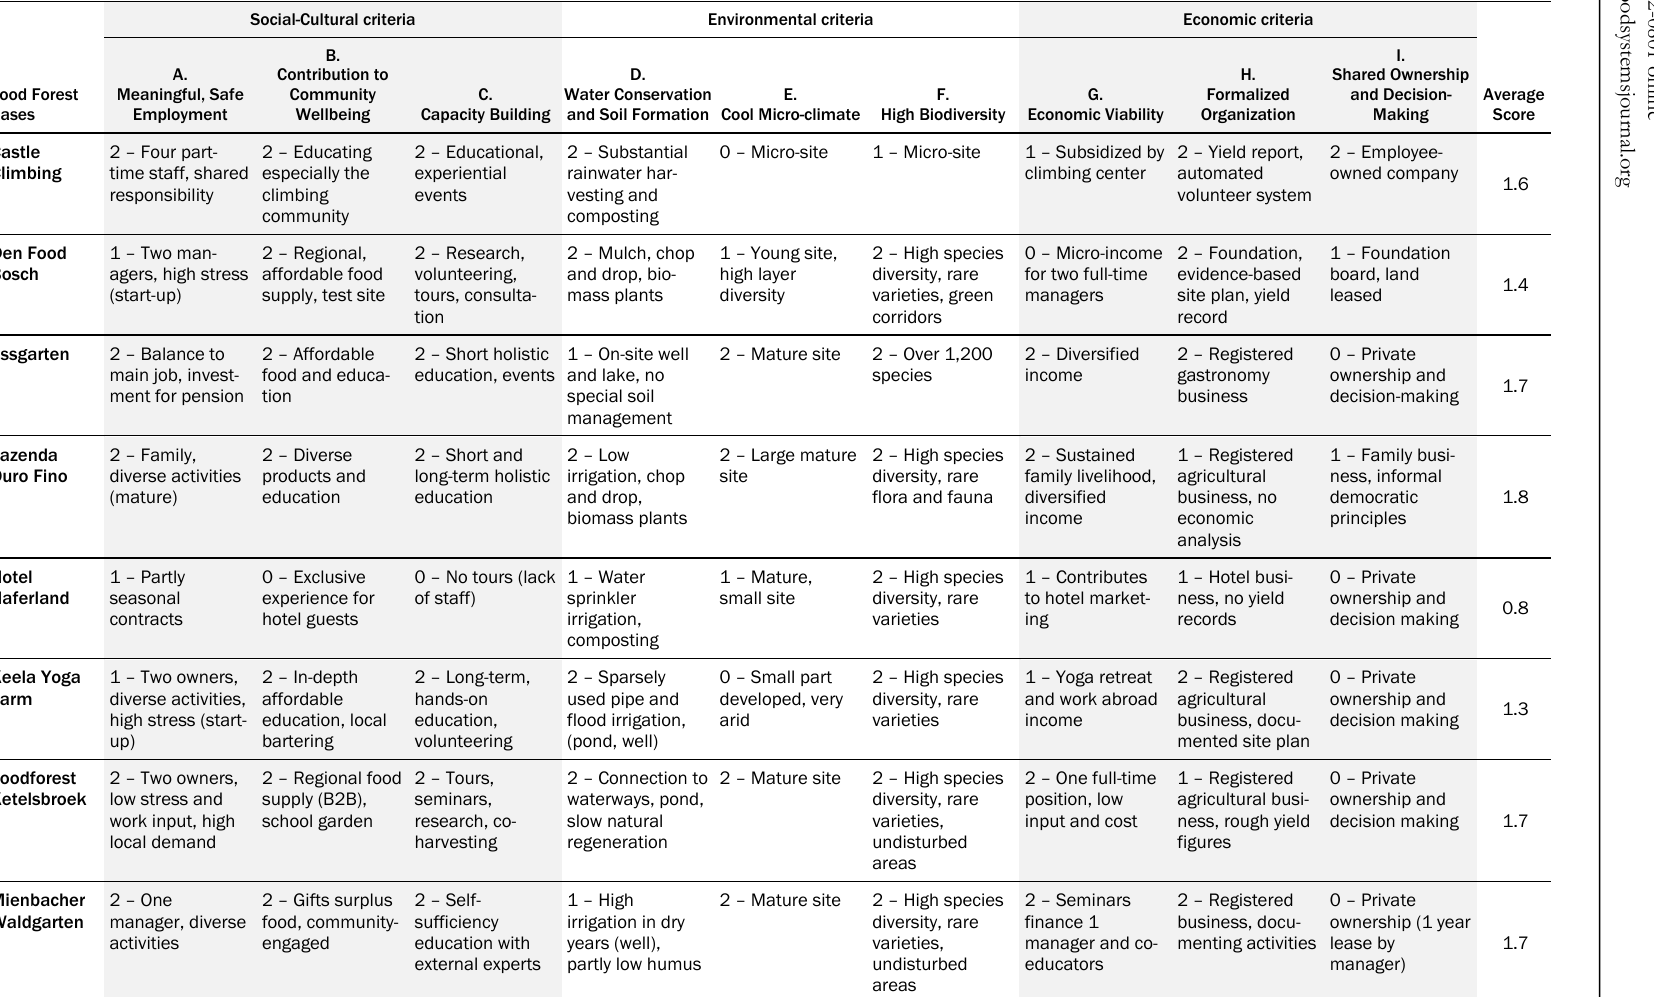
Table 3. Overview of Sustainability Assessment of 14 Food Forests by Social-Cultural, Environmental, and Economic Criteria Food forests are listed in alphabetical order, scores indicate that criteria are Fully (2), Somewhat (1), or Not (0)